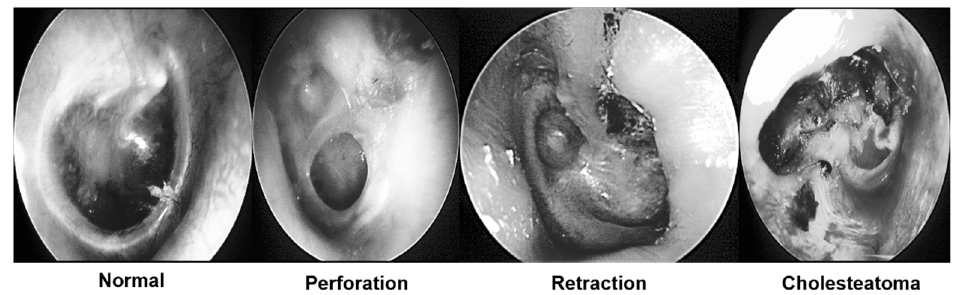
Figure 4. Image after applying adaptive histogram equalization.